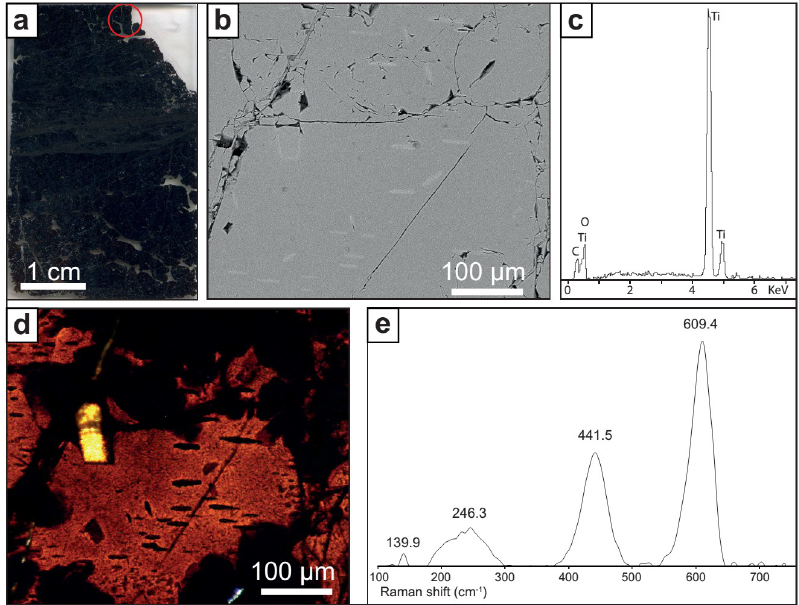
Figure 4. Oriented clinopyroxene lamellae in the Mercedita chromite: ( a ) Thin section containing the clinopyroxene lamellae showed in the images ( b , c ). The location of the studied lamellae is showed with a red circle; ( b ) Backscattered electron (BSE) image of oriented pyroxene lamellae defining two main directions; ( c ) Zoom of one sub‐micron clinopyroxene lamellae of image ( b ); ( d ) Energy‐Dispersive Spectroscopy (EDS) spectra of the clinopyroxene of image ( b ), showing qualitatively its chemical composition. The elements marked with an asterisk correspond to the chromite host; ( e ) Raman spectra of the diopside after subtraction of the chromite background.